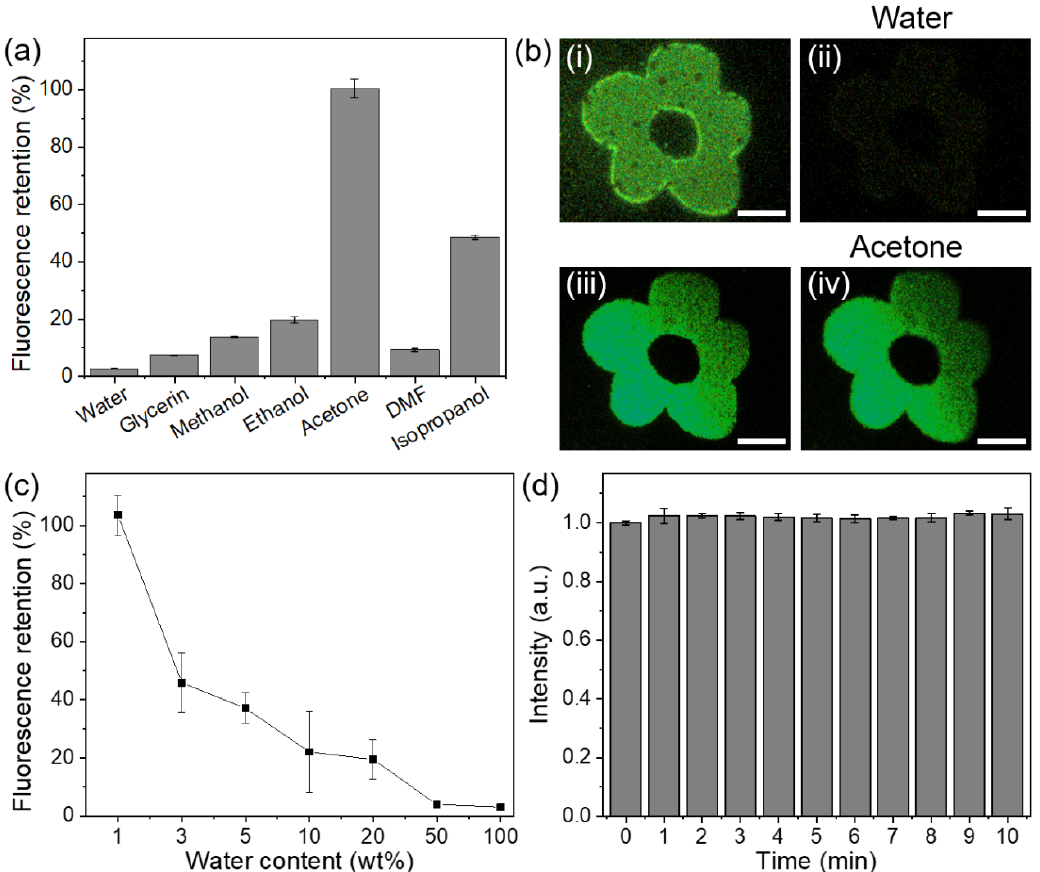
Figure 3. Reagent sensing characteristics of the fluorophores. ( a ) Fluorescence retention of different solvents on the laser-modified PVA samples. ( b ) Fluorescence images of two patterned PVA samples before and after water ( i , ii ) and acetone ( iii , iv ) dropping, respectively. The scale bars are 50 µm. ( c ) The fluorescence retention as a function of water content in acetone. ( d ) Fluorescence intensities of the laser-modified PVA after continuous exposure to 488-nm-wavelength excitation. The intensities are normalized to the first measurement.